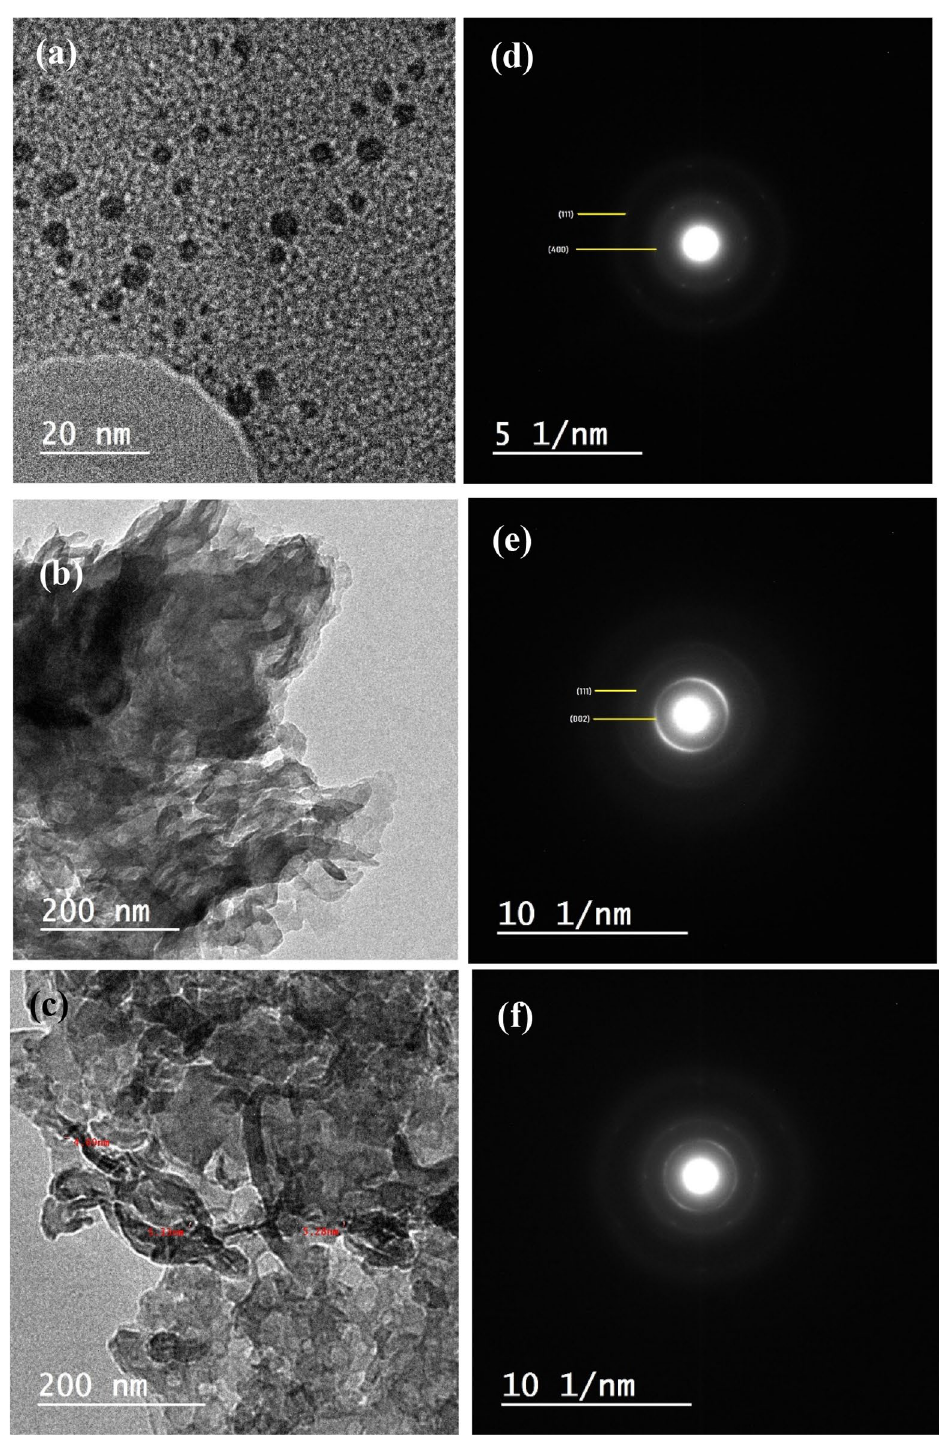
Figure 8. The HRTEM with corresponding SAED of ( a ) GQDs, ( b ) g-C3N4, and ( c ) GQDs/g-C3N4, ( d ) SAED of GQDs, ( e ) SAED of g-C3N4, and ( f ) SAED of